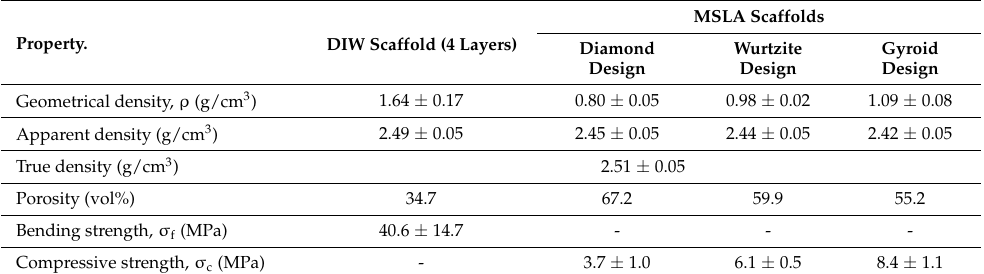
Figure 7. Reference three ‐ dimensional models adopted for MSLA scaffolds: ( a ) diamond symmetry; ( b ) wurtzite symmetry; ( c ) gy ‐ roid.